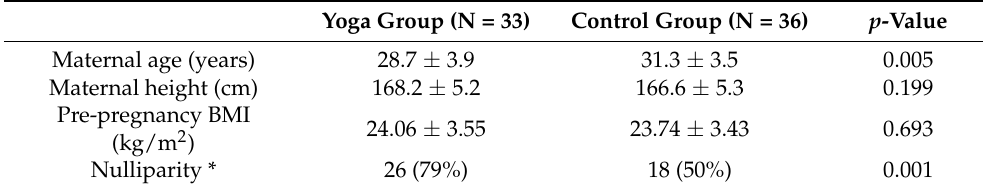
Table 1. Characteristics of study